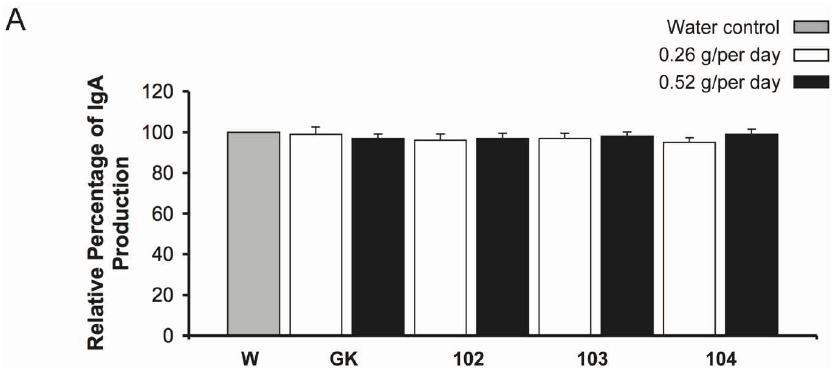
Figure 4. Serum antibody levels of immunoglobulin A (IgA) and IgE, and stimulation of immune cells in mice fed ipt -transgenic broccoli. ( A ) IgA level; ( B ) IgE level. Antibody level for control-water–fed mice (gray column) was set to 100%. Data are mean ± SD of triplicate experiments ( n = 8); Stimulation index for ( C ) T cells and ( D ) B cells. Data are mean ± SD of triplicate experiments ( n =